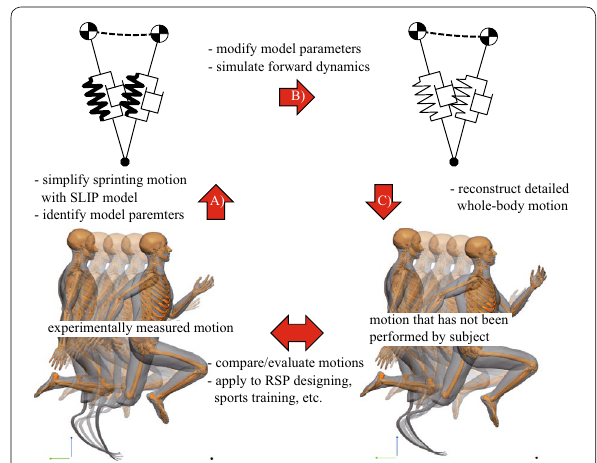
Fig. 1 Concept chart of multilayered kinodynamics simulation of motion modification. This simulation consists of three steps: A sim- plify the sprinting motion with the SLIP model and identify its param- eters using experimentally measured motion, B modify the identified model parameters and simulate the forward dynamics of the simple model, and C reconstruct the detailed whole-body motion from the motion of the simple